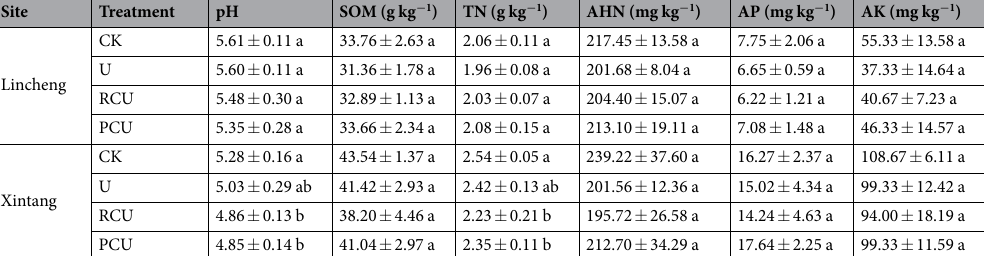
Table 6. Soil pH, SOM, TN, AHN, AP and AK at the 0–20 cm depth were affected by different treatments at the two experimental sites in 2016. The values are presented as the mean ± standard deviation (n = 3). Different letters in the same columns at the same site represent significant differences at the level of P < 0.05. CK, U, RCU and PCU represent no N application, conventional urea, resin-coated urea and polyurethane-coated urea, respectively. SOM, TN, AHN, AP and AK represent soil organic matter, total N, alkaline hydrolyzable N, available P and available K,